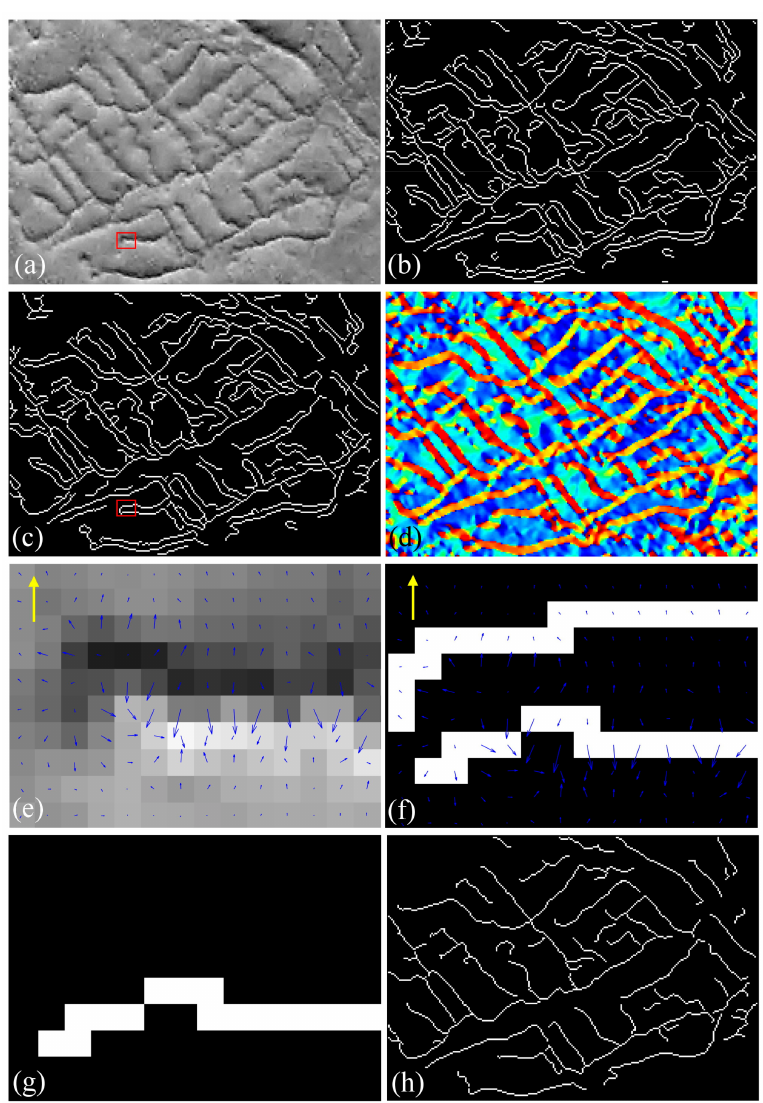
Figure 8. Results of edge detection applied to the area enclosed by the red box in Figure 7d: ( a ) morphologically enhanced image; ( b ) results of the Canny operator; ( c ) results of the geometric filter; ( d ) gradient direction map of ( a ); ( e ) gradient vector sub-map covering the area enclosed by red boxes in ( a ); ( f ) gradient vector displayed on the red boxes in ( c ); ( g ) image in ( f ) after shadow edge removal; and ( h ) the edges in ( a ) after the removal of false edges. The blue and yellow arrows in ( e , f ) represent the gradient vectors and the directional illumination vectors in the image plane,